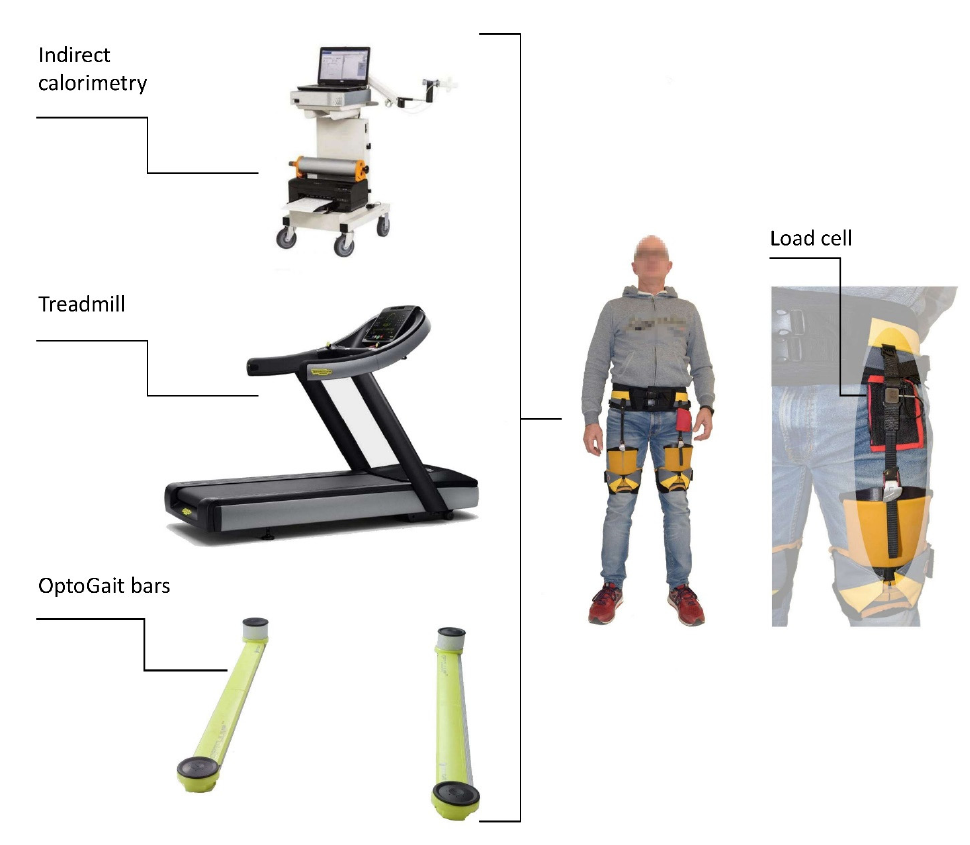
Figure 2. Overview of the experimental instrumentation adopted in the study.